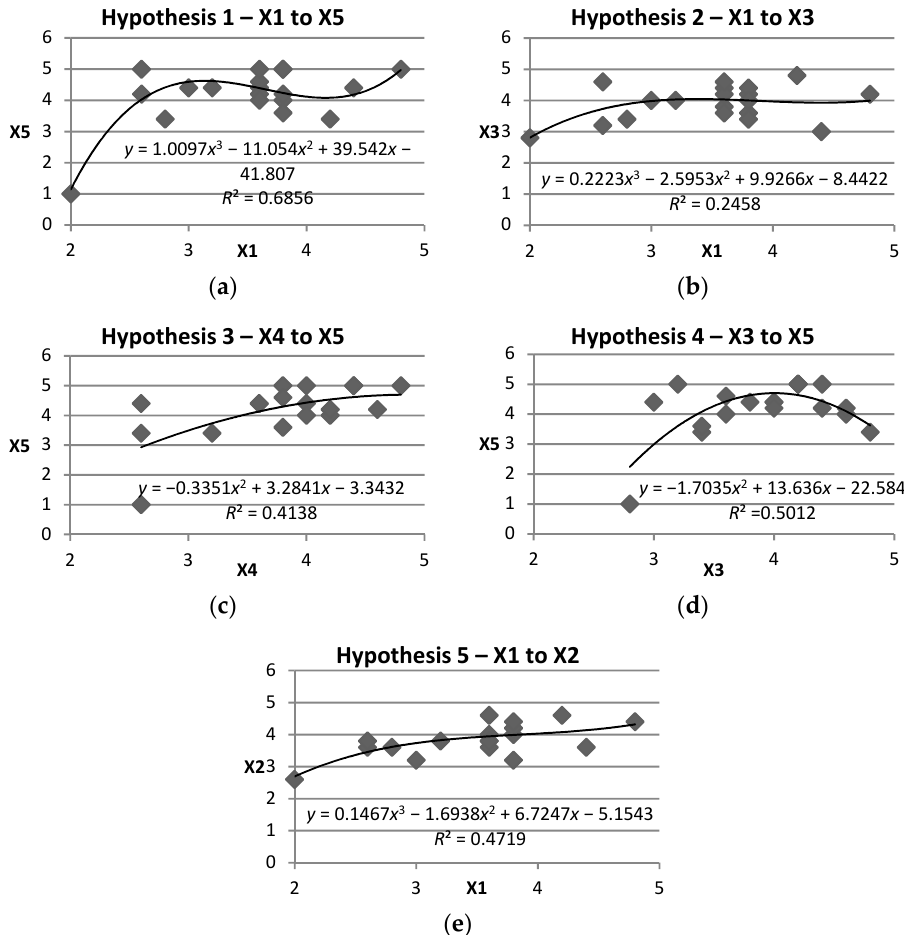
Figure 3. Relationships between variables within the framework of the hypotheses: ( a ) Hypothesis 1—X1 to X5; ( b ) Hypothesis 2—X1 to X3; ( c ) Hypothesis 3—X4 to X5; ( d ) Hypothesis 4—X3 to X5; ( e ) Hypothesis 5—X1 to X2.